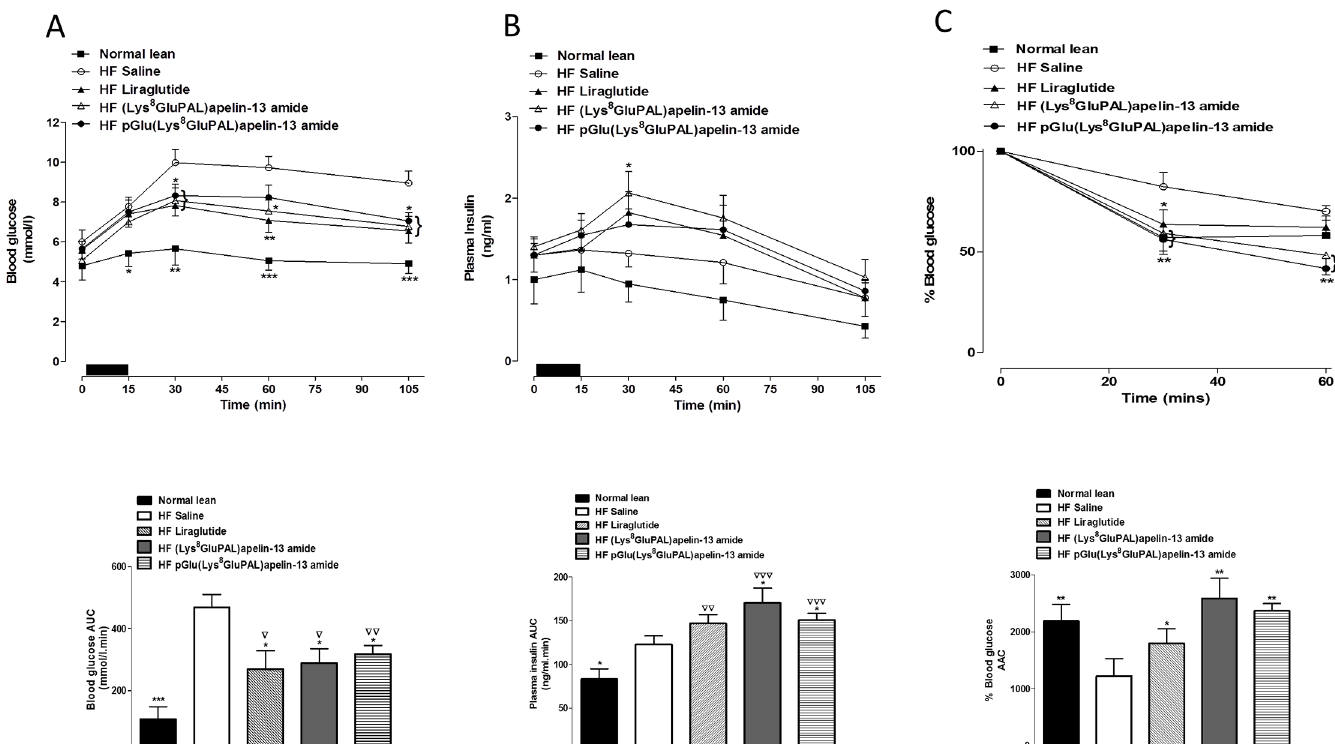
Fig 3. Effect of once daily i.p. administration of liraglutide, (Lys 8 GluPAL)apelin-13 amide or pGlu(Lys 8 GluPAL)apelin-13 amide (each at 25 nmol/kg) on blood glucose (A) and plasma insulin (B) responses to 15 min feeding (A, B) and insulin sensitivity (C) in high-fat fed mice. Tests were performed after 28-days. For meal tests, mice were fasted for 18 h previously and given free access to normal diet for 15 min. The period of feeding is represented by the black horizontal bar. Blood glucose and plasma insulin (AUC) values are also included. For insulin sensitivity tests, insulin (25 U/kg body weight) was administrated by i.p. injection in the fed state. The % blood glucose and AAC values (C) for 0–60 min post-injection are shown. Values represent the mean ± S.E.M. (n = 8) where (cid:3) p < 0.05, (cid:3)(cid:3) p < 0.01 and (cid:3)(cid:3)(cid:3) p < 0.001 is compared to high-fat fed saline treated mice, 5 p < 0.05, 55 p < 0.01 and 555 p < 0.001 compared to normal mice.